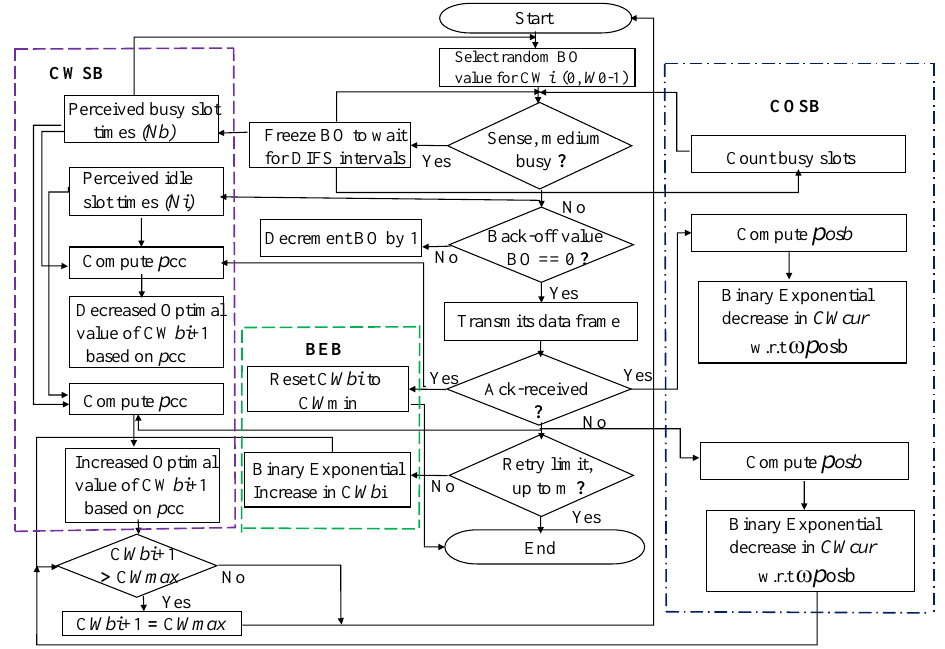
Figure 5. Flow chart comparison of BEB, COSB and the proposed CWSB